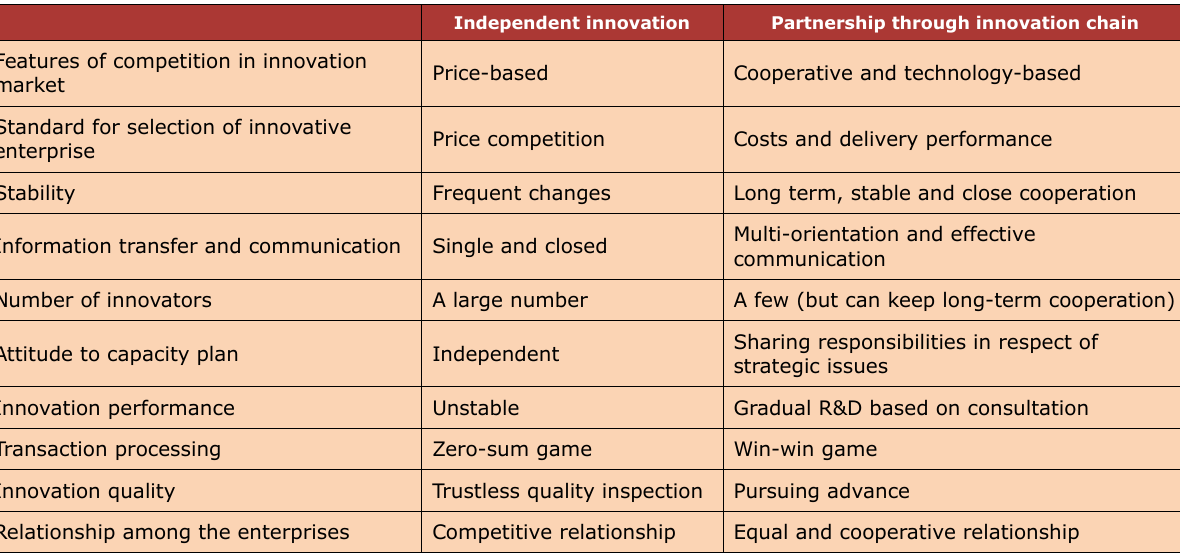
Table 1. Comparison of Innovation Chain and Independent Innovation of